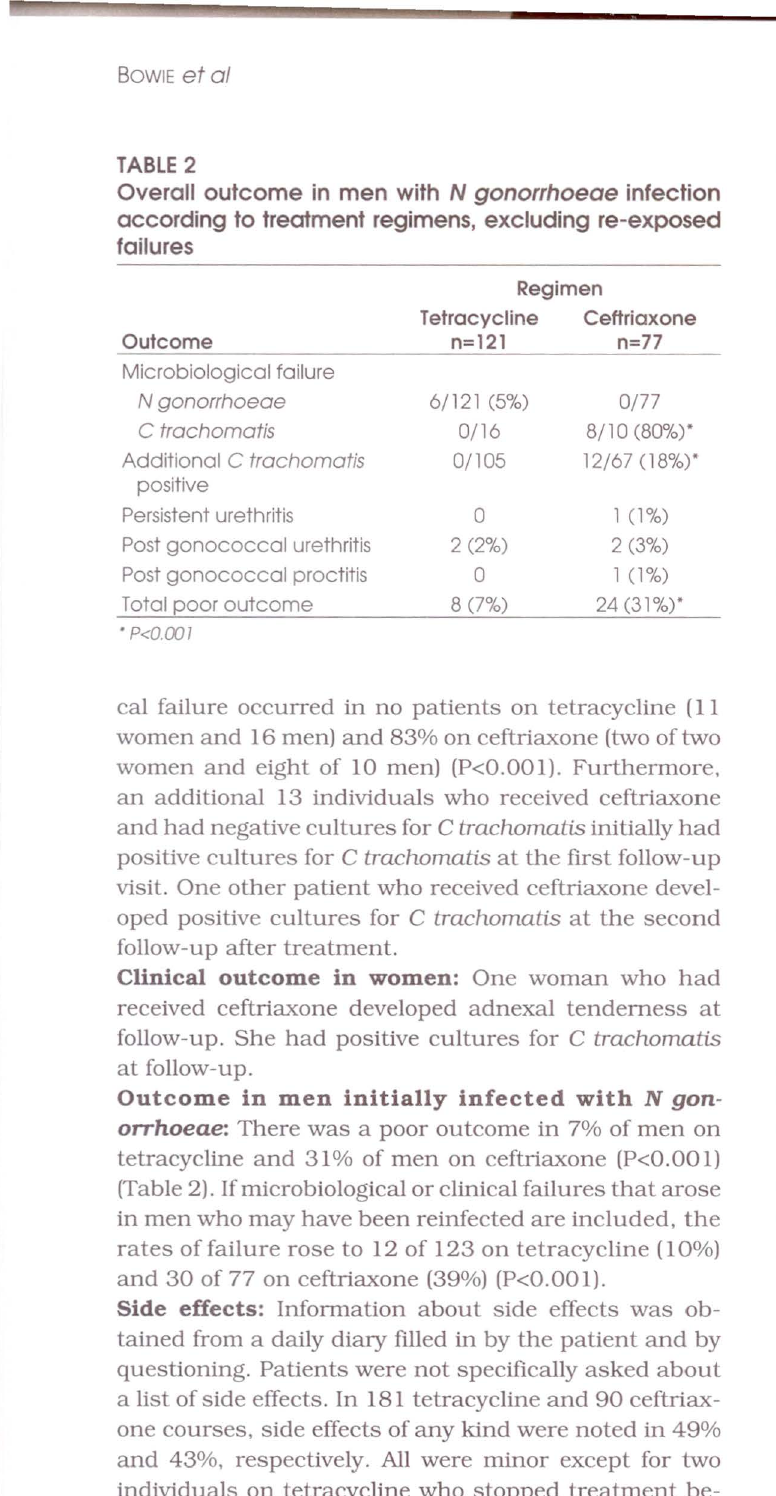
TABLE 2 Overall outcome in men with N gonorrhoeae infection according to treatment regimens, excluding re-exposed failures